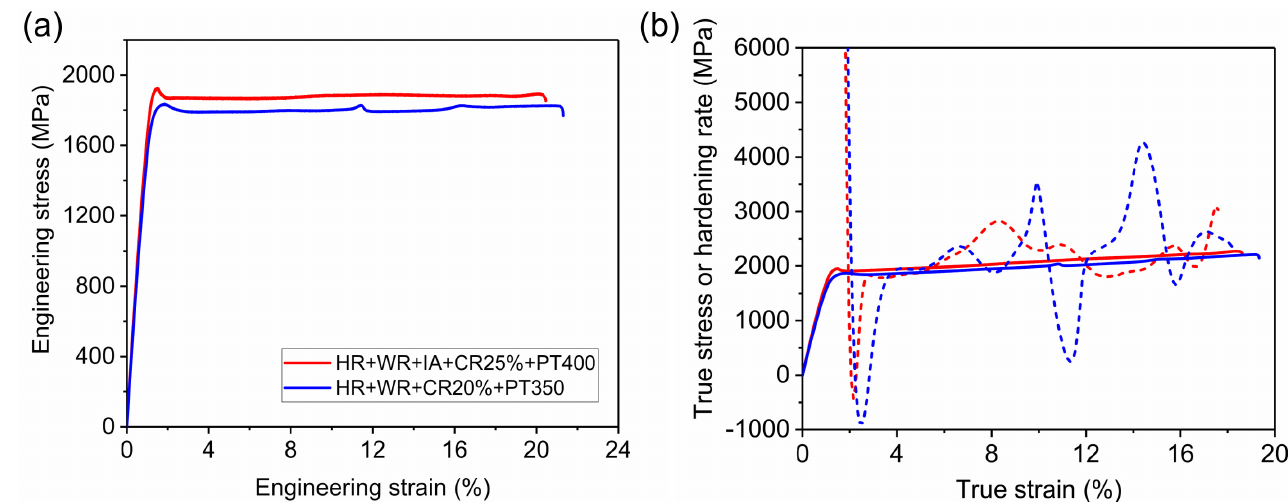
Figure 9. ( a ) Engineering stress–strain curves of the HR + WR + IA + CR25% + PT400 sample and the HR + WR + CR20% + PT350 sample. ( b ) The corresponding true stress–strain curves (solid line) and work hardening rate curves (dotted line).